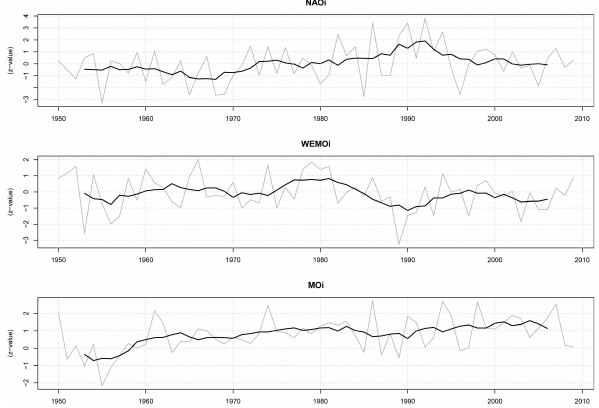
Fig. 9. Temporal evolution of October to March NAO, WeMO and MO indices obtained from average daily indices (thin black line) and 5-yr running average (thick grey line).